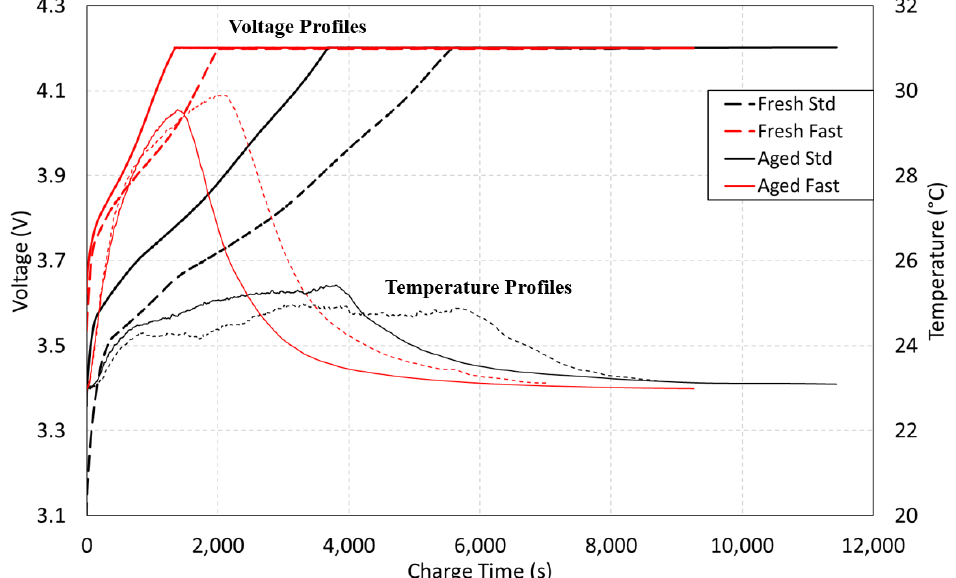
Figure 7. Charging process over time, for a fresh and a high current charge aged cell, under standard (0.5 C) and high current (1 C) charge methods. (0.5 C) and high current (1 C) charge